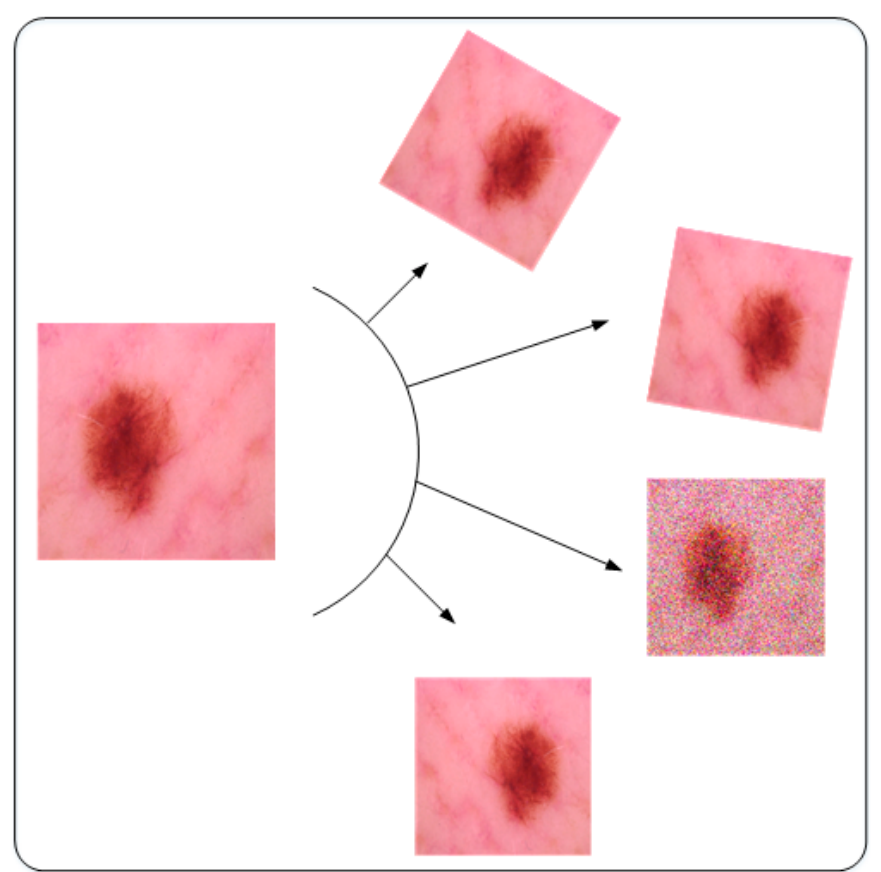
Figure 3. Visual illustration of the augmentation techniques.